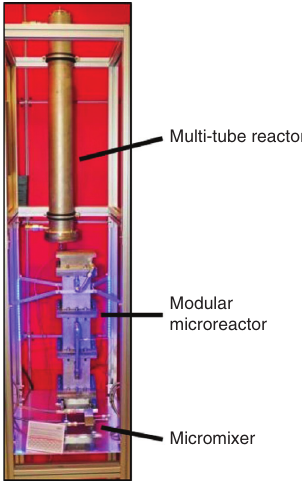
Figure 1 Modular multi-scale reactor (IMM) for the continuously operated synthesis of ionic